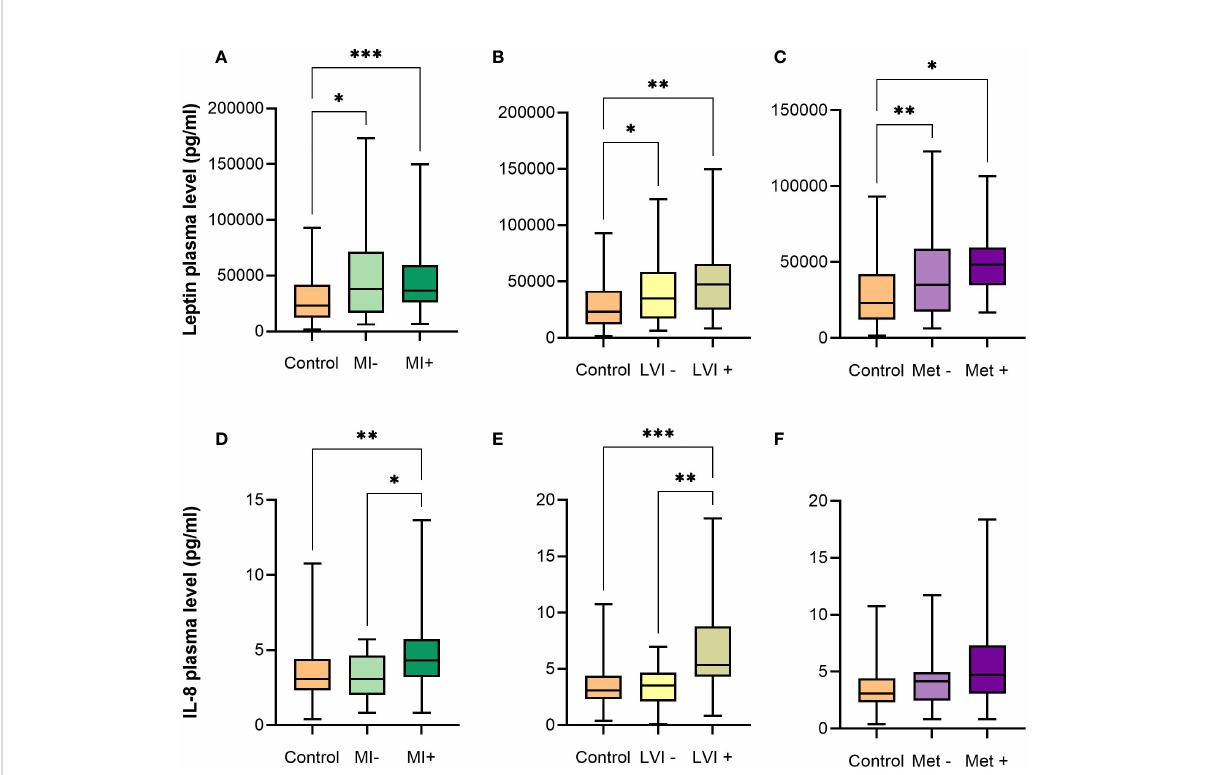
FIGURE 2 Box plots with median, minimum and maximum for plasma leptin and IL-8 levels (pg/mL). (A, D) Control patients and EC patients with absence or presence of myometrial invasion. (B, E) Control patients and EC patients with absence or presence of lymphovascular invasion. (C, F) Control patients and EC patients with absence or presence of metastasis. EC – endometrial cancer, MI – myometrial invasion, LVI – lymphovascular invasion, Met – metastasis. Adjusted p values: *p < 0.05, **p < 0.01, ***p <